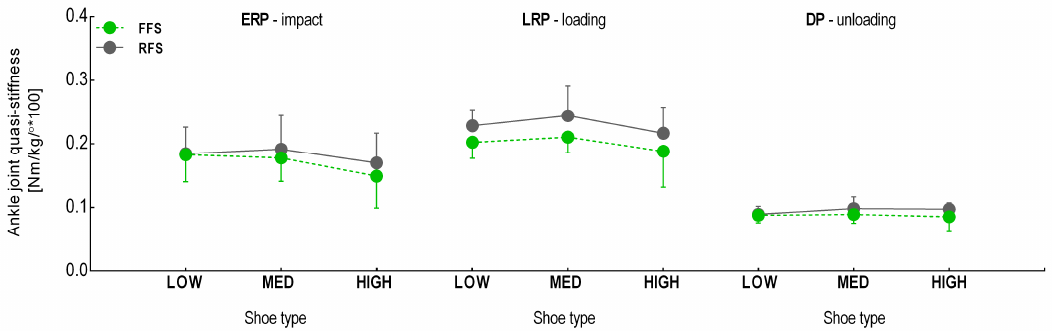
Figure 2. Mean and SD values for ankle joint dynamic stiffness of FFS and RFS for the three phases of stance, in the three shoe conditions. ERP early rising phase, LRP late rising phase, DP descending phase. Shoes conditions are termed as low-MI (LOW), medium-MI (MED) and high-MI (HIGH). MI: minimalist indexes. FFS: forefoot strikers. RFS: rearfoot